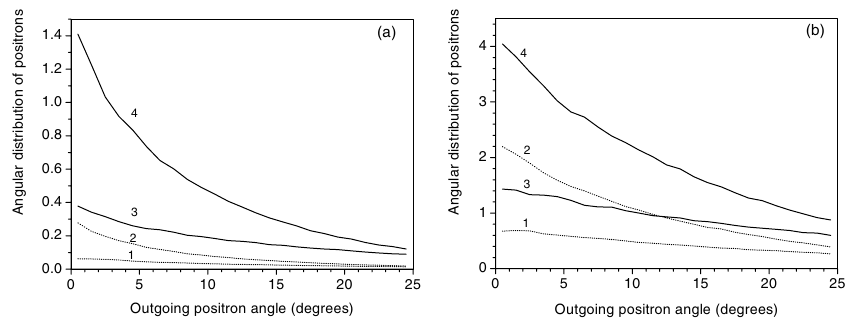
FIG. 5. Angular distribution dN (cid:9)(cid:4)(cid:10) =d (cid:30) depending on outgoing positron angle at L (cid:16) 2 : 2 mm (a) and at L (cid:16) 9 : 0 mm (b) for p 2 (cid:9) 8 : 5 – 11 : 5 (cid:10) Mev =c (curves 1 and 3) and for p 2 (cid:9) 17 – 23 (cid:10) Mev =c (curves 2 and 4). Solid curves represent the yield from crystal and dotted curves from amorphous targets.